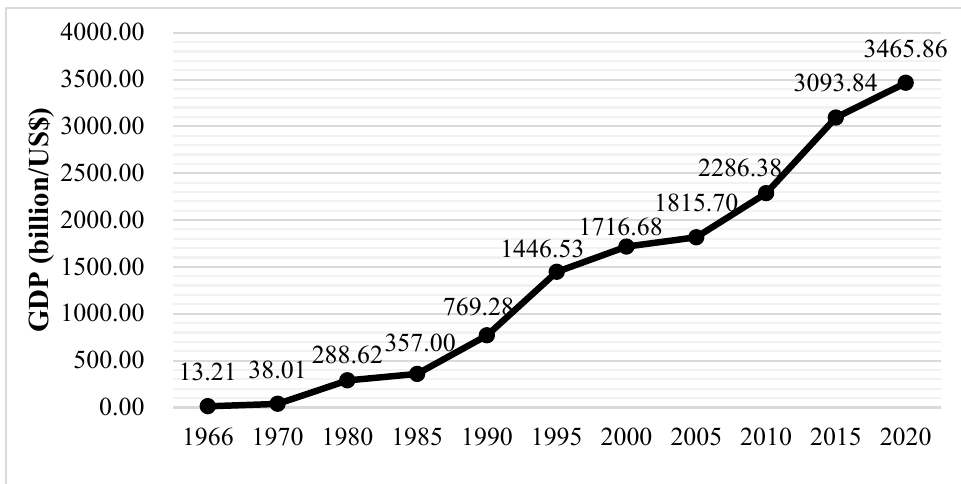
Figure 6. Line chart of Hong Kong’s GDP, 1966–2020 (Source: World Bank, IMF).